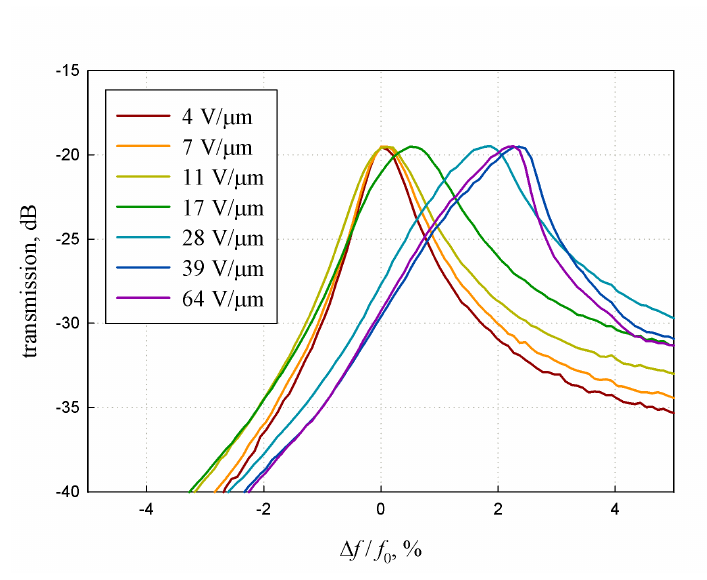
Figure 3. Shift of the resonance characteristics under the microwave power (at the different magnitude of electric field